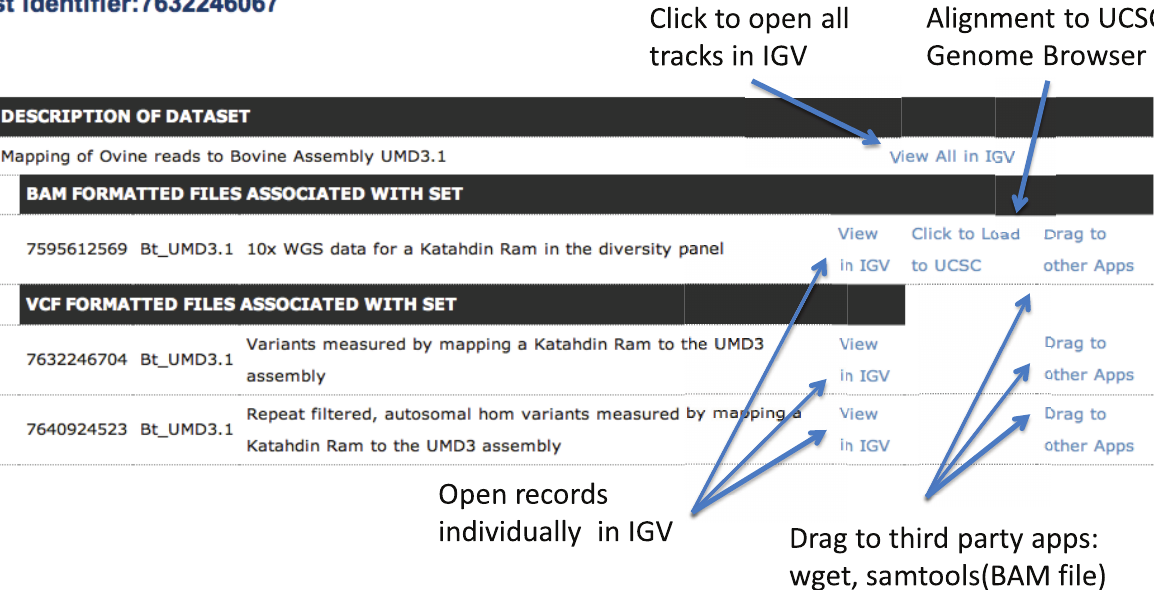
as to how much variation is tolerated in an otherwise conserved region. However, for the purpose of intraspecies variation detec- tion, homozygous variants derived from a single animal should be ignored. This problem could be mitigated if more animals were used since that would dramatically increase the number of alleles repre- sented and greatly increase the likelihood that a heterozygote would be measured. The majority of heterozygotes will represent a pair of alleles present in this animal, and therefore intra-species